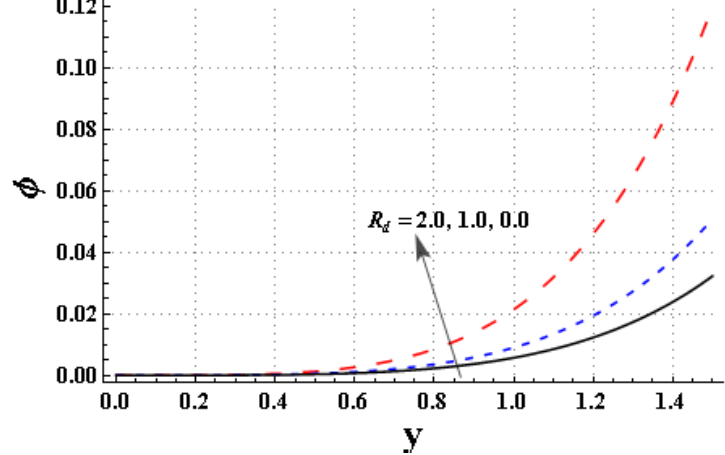
R R R on the concentration of nanomaterials, on the concentration of nanomaterials, on the concentration of nanomaterials,